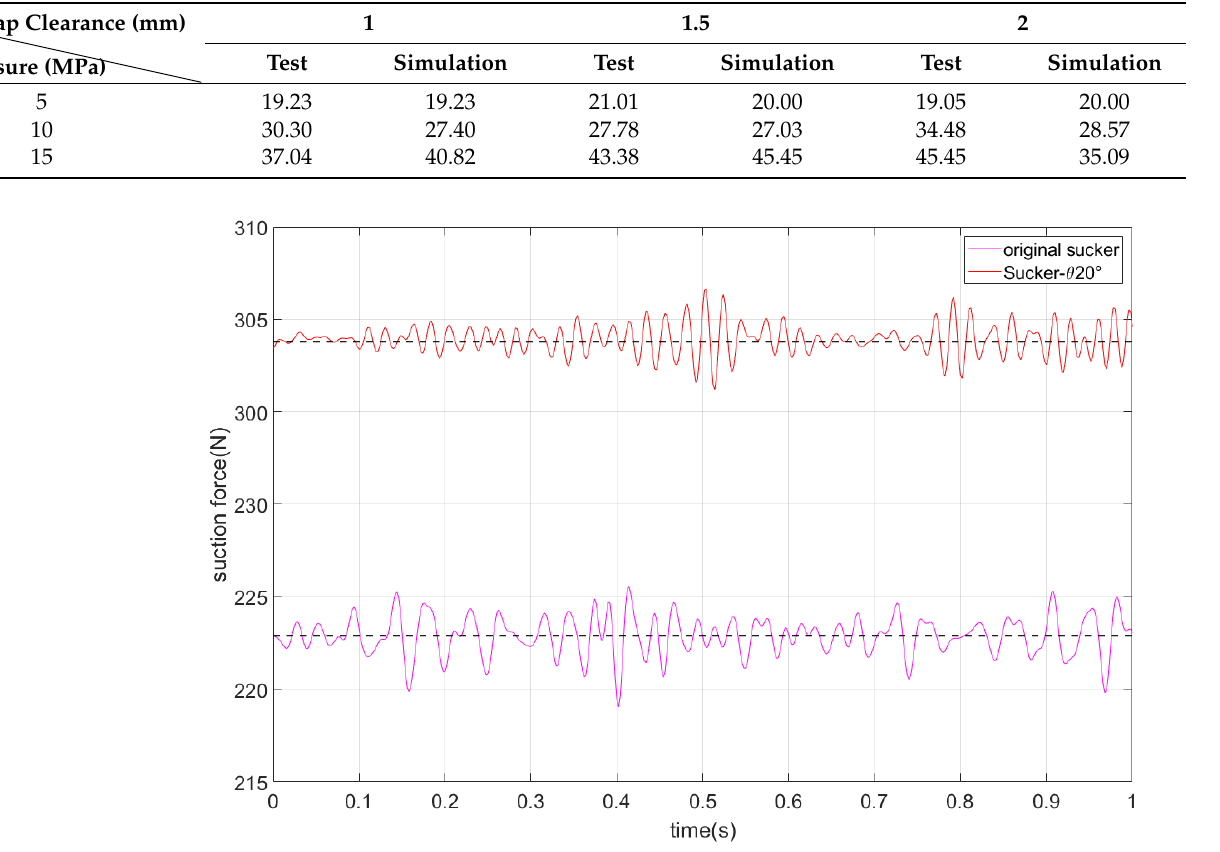
Figure 34. Comparison of experimental results of suction force between the original suction cup and suction cup- θ 20 at an inlet pressure of 15 MPa and gap of 1.5 mm. suction cup- θ 20 at an inlet pressure of 15 MPa and gap of 1.5